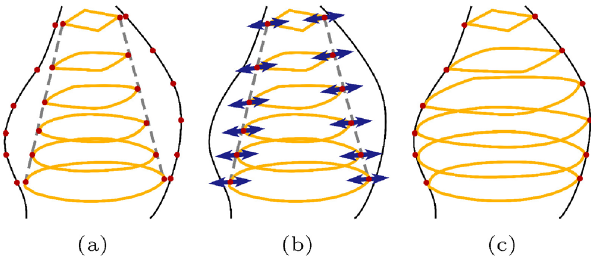
Fig. 4 Adjusting the intermediate curves to fit the silhouette. (a) We first compute two approximate boundary points for each curve by linear interpolation and use them to find the real boundary points. (b) We expand each curve on its underlying plane in 3D. (c) The resulting shape; sections’ sizes match the silhouette.